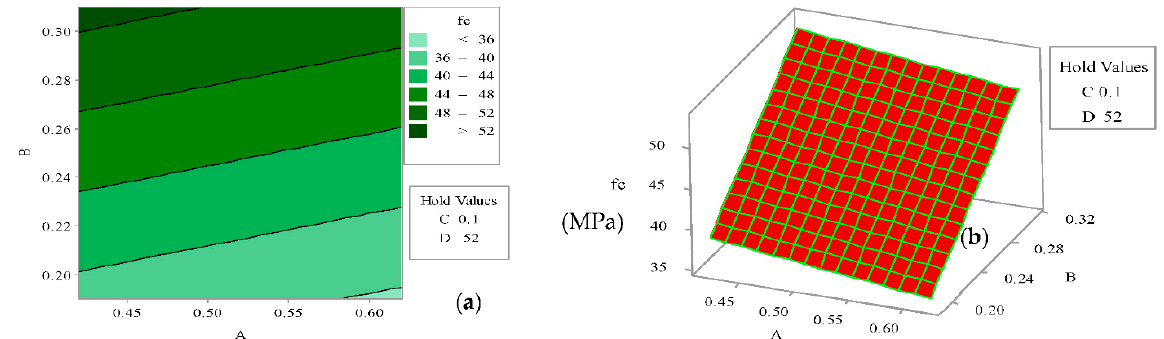
Figure 10. Effects of B and A on fc (MPa) ( a ) 2-D contour lines ( b ) 3-D surface. A is water/binder ratio, B is binder/aggregate ratio, C is CNA/(CNA + PLC), and D is curing age (d).